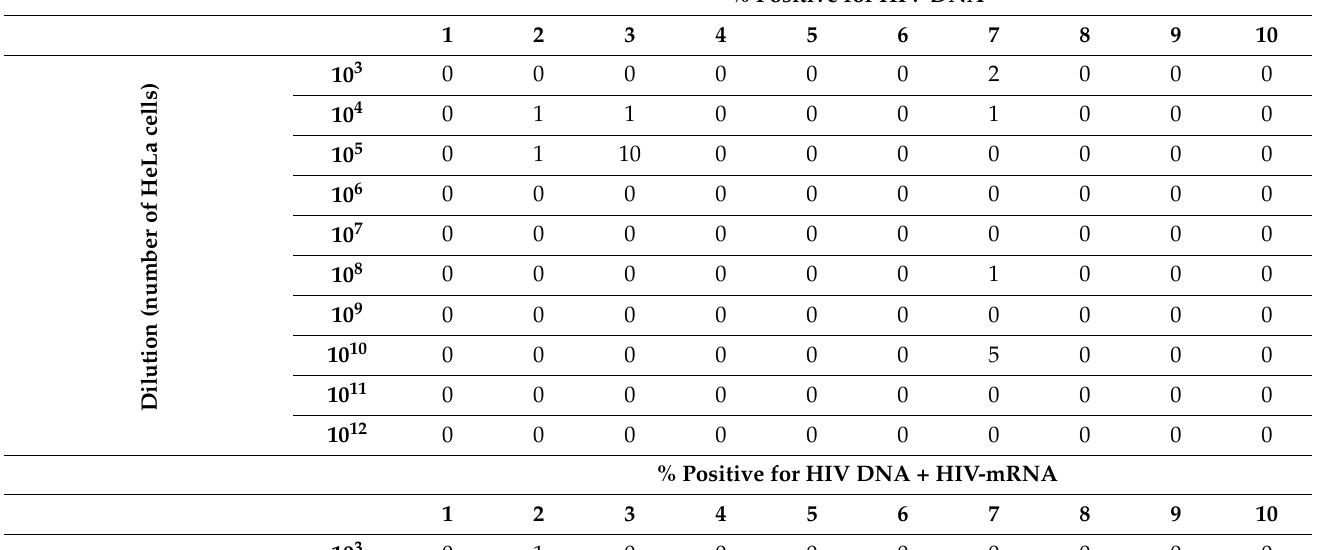
Table 2. Detection of HIV DNA, HIV-mRNA, and HIV protein in uninfected HL-60 cells. We diluted uninfected control cells (HL-60) to calculate our image system’s sensitivity to detect viral reservoirs. One to ten cells were diluted in 10 3 to 10 12 HeLa cells. Then, staining for HIV DNA (top), HIV-mRNA (middle), or HIV-p24 protein (bottom) was performed to identify whether we could detect the diluted cells in the HeLa cells. The percentage of detection is indicated for 10 sample preparations for each dilution. Pellets of these cells were cut and analyzed by microscopy to identify the infected cells. % Positive for HIV